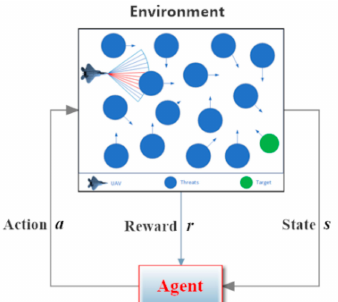
Figure 1. Reinforcement learning based (RL-based)motion control structure of the unmanned aerial vehicle (UAV).